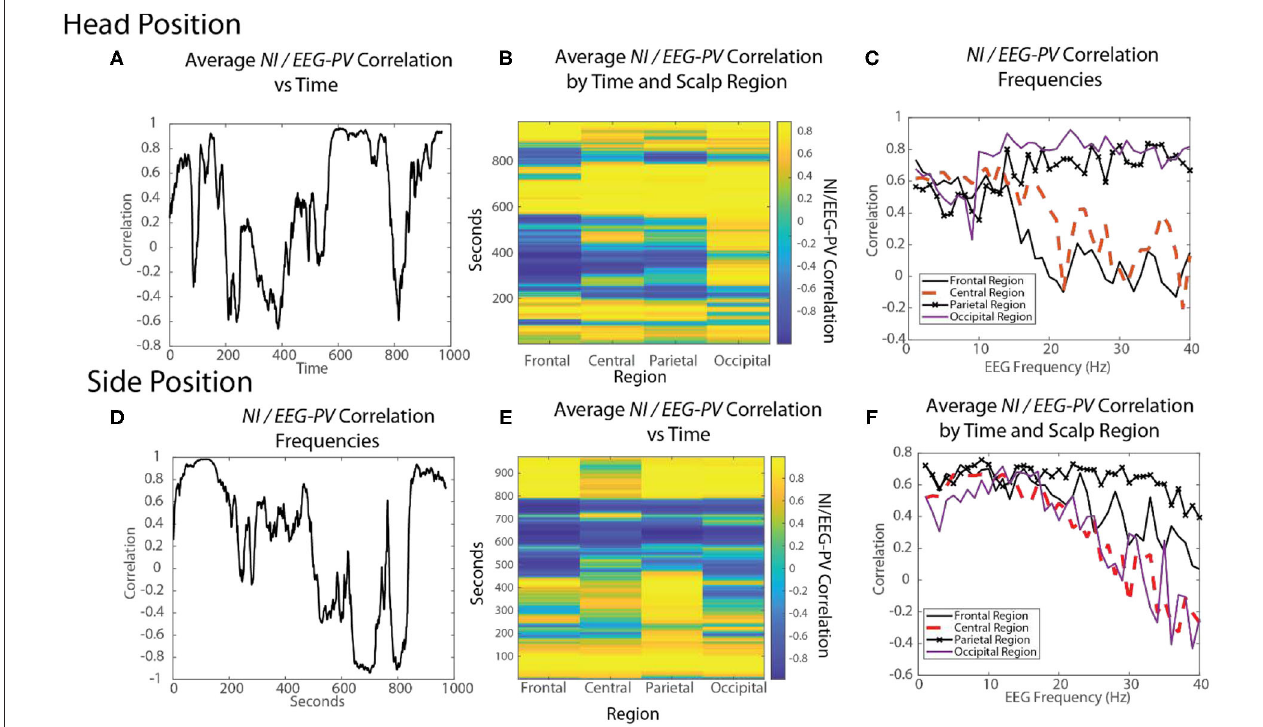
FIGURE 10 | The changing relationships of NI and EEG-PV during an ecologically valid task. The correlation between parallel NI and EEG-PV data streams were measured for FN-H (top) and FN-S during a Life flight performance (LF1). The correlation data was aggregated across the scalp (A,D) , regions of the scalp (B,E) or at the EEG frequency level for regions of the scalp (C,F)